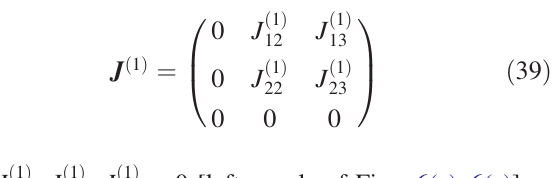
Jordan form Order of correlations